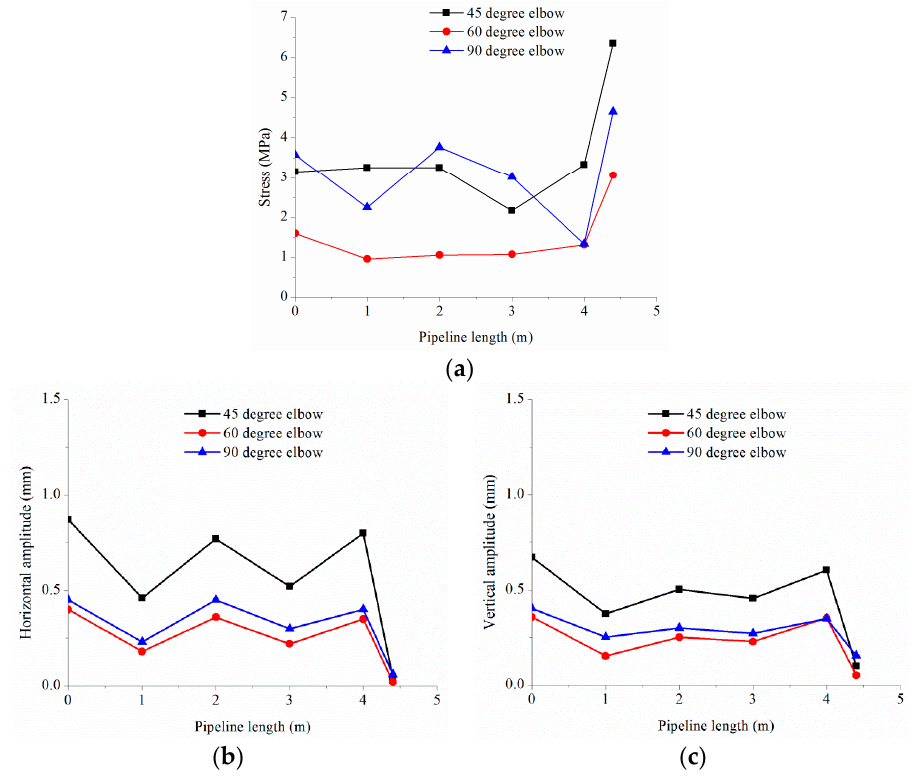
Figure 11. Test results of pipeline: ( a ) stress; ( b ) horizontal amplitude; ( c ) vertical amplitude.